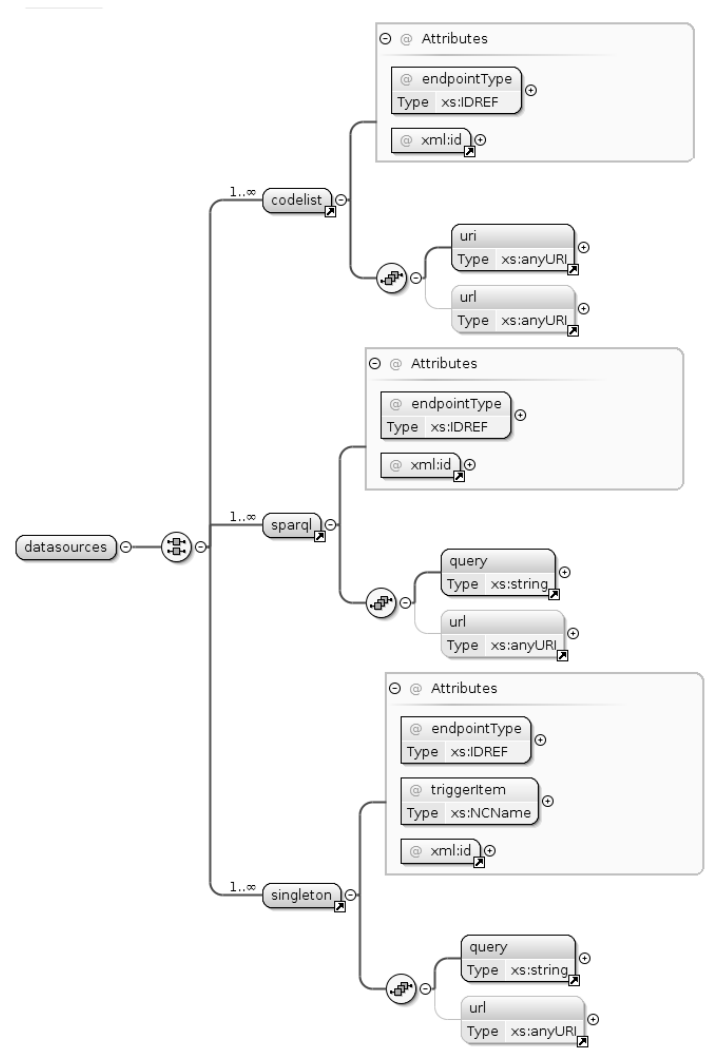
Figure 4. The datasource schema